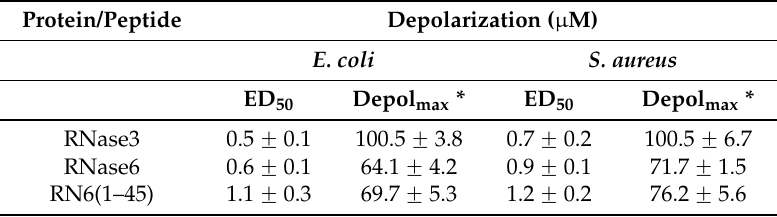
Table 5. Depolarization activity on E.coli and S.aureus cells determined for RNase3, RNase6 and